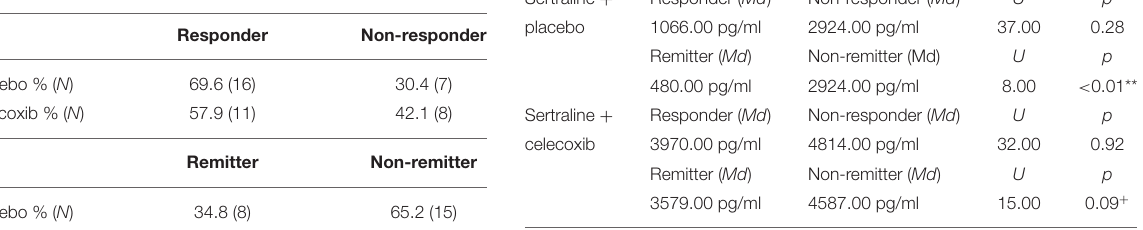
TABLE 3 | Response and remission rates of MDD patients in each treatment arm.